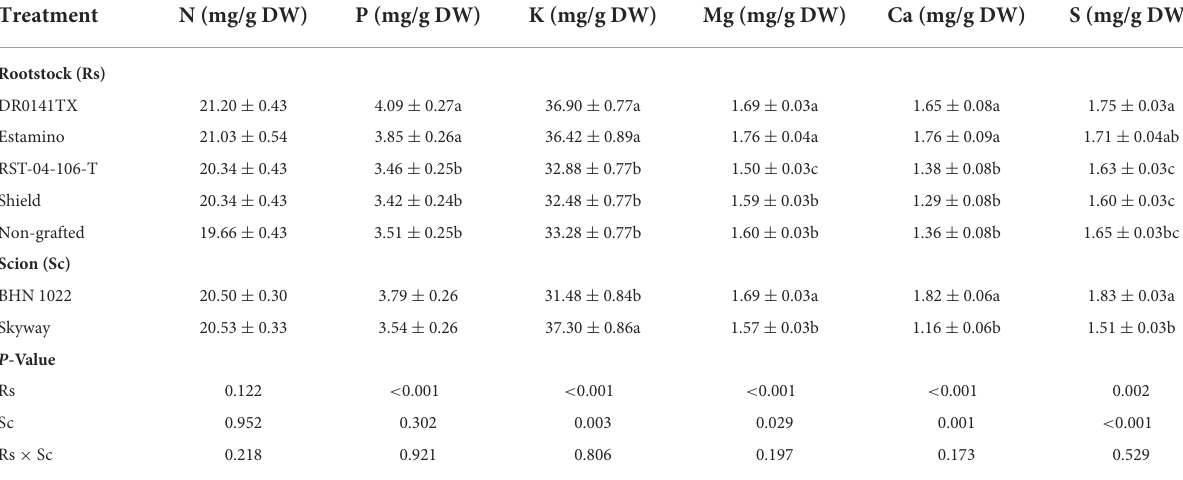
TABLE 7 Fruit macronutrient content on a dry weight basis in tomatoes as affected by rootstock and scion cultivars in the spring planting (14 February to 18 June 2020).